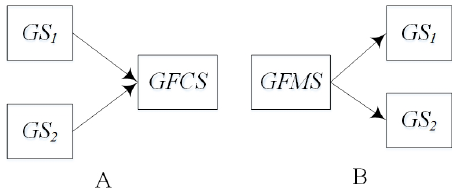
Figure 6. The composition and mapping of GIS-oriented IoT service